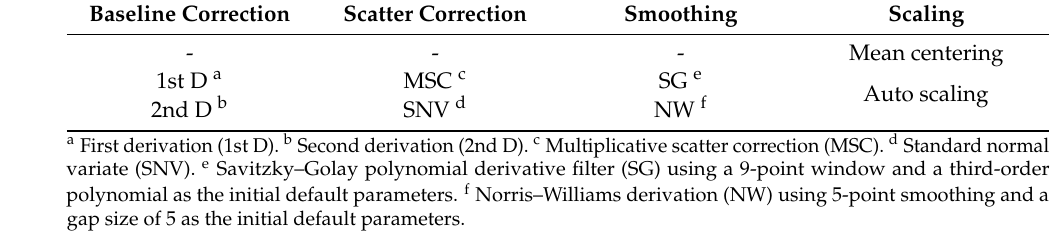
Table 3. Potential optimal pretreatment combinations for the TS content models.